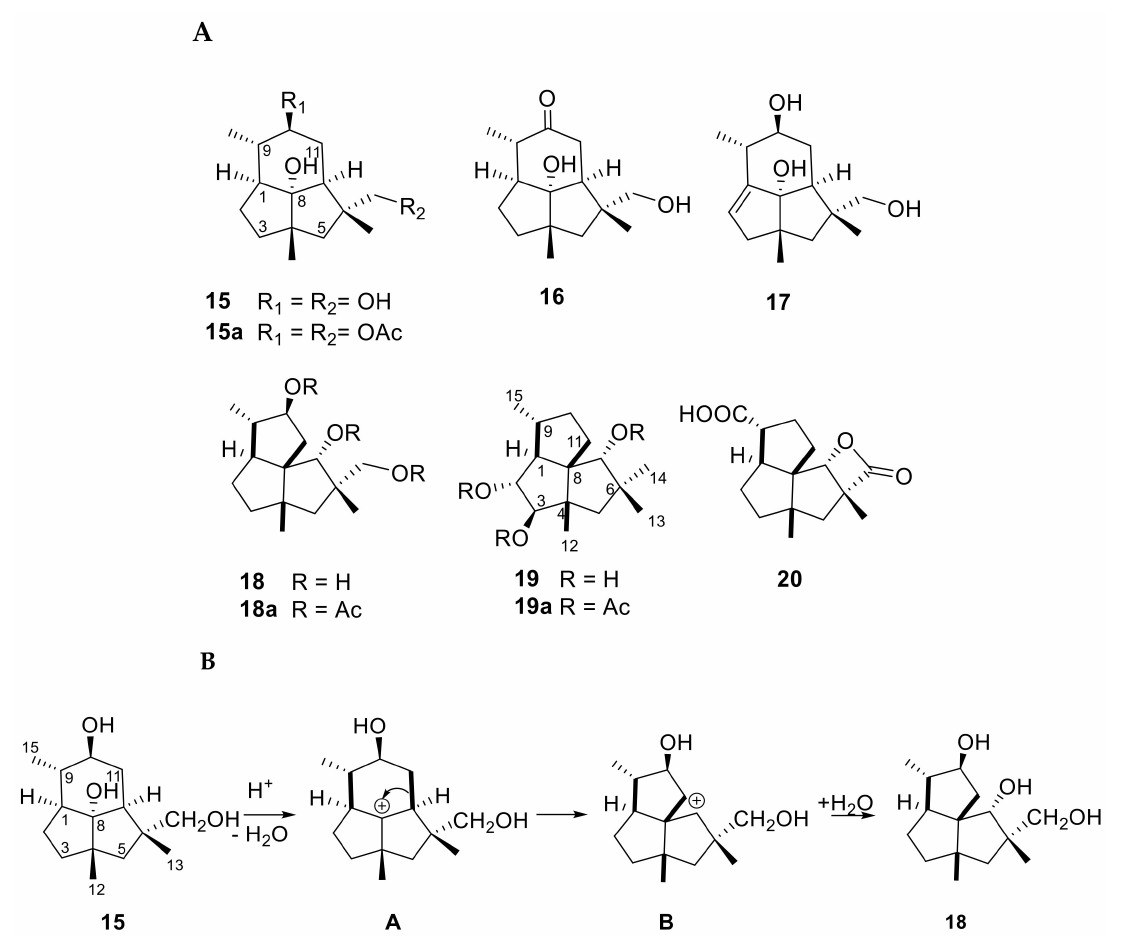
Figure 10. ( A ) Presilphiperfolanes and cameroonanes isolated from the bcbot-4 knock-out mutant fermentation. ( B ) Rearrangement of the presilphiperfolane to cameroonane